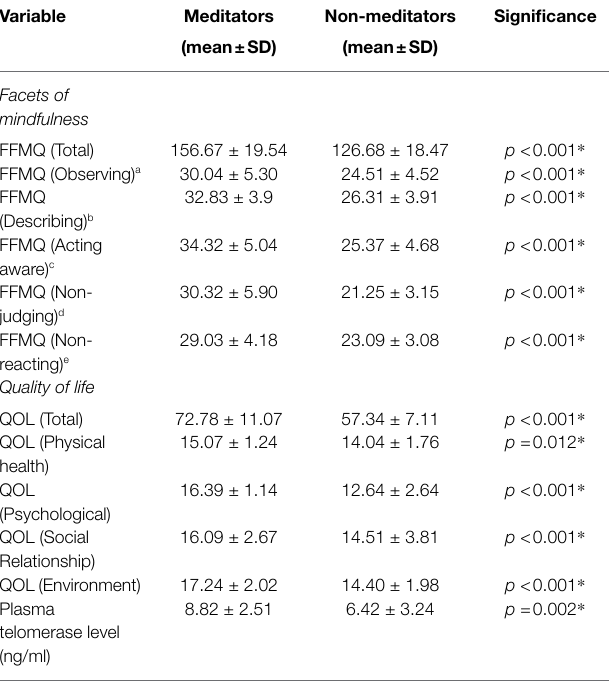
TABLE 2 | Mindfulness, wellbeing, and plasma telomerase concentration in mediators and non-meditators.